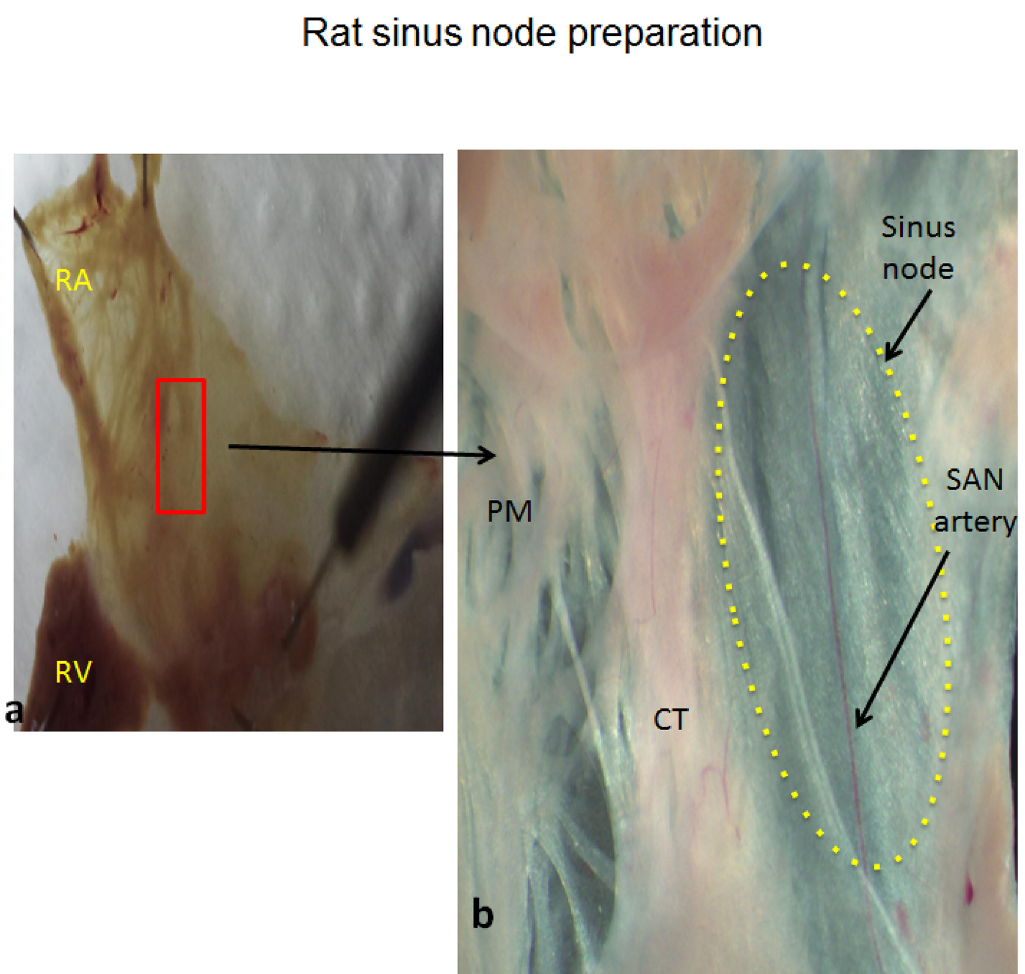
Fig 1. a & b – Gross anatomy of the sinus node in a typical control heart showing the location where tissue samples were